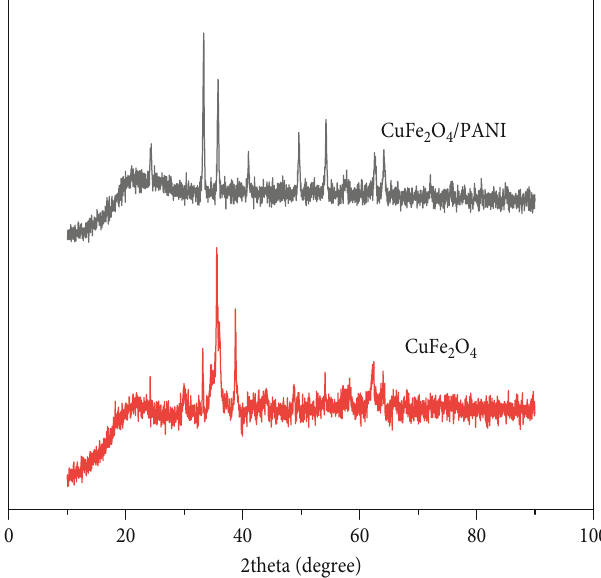
Figure 2: XRD of CuFe